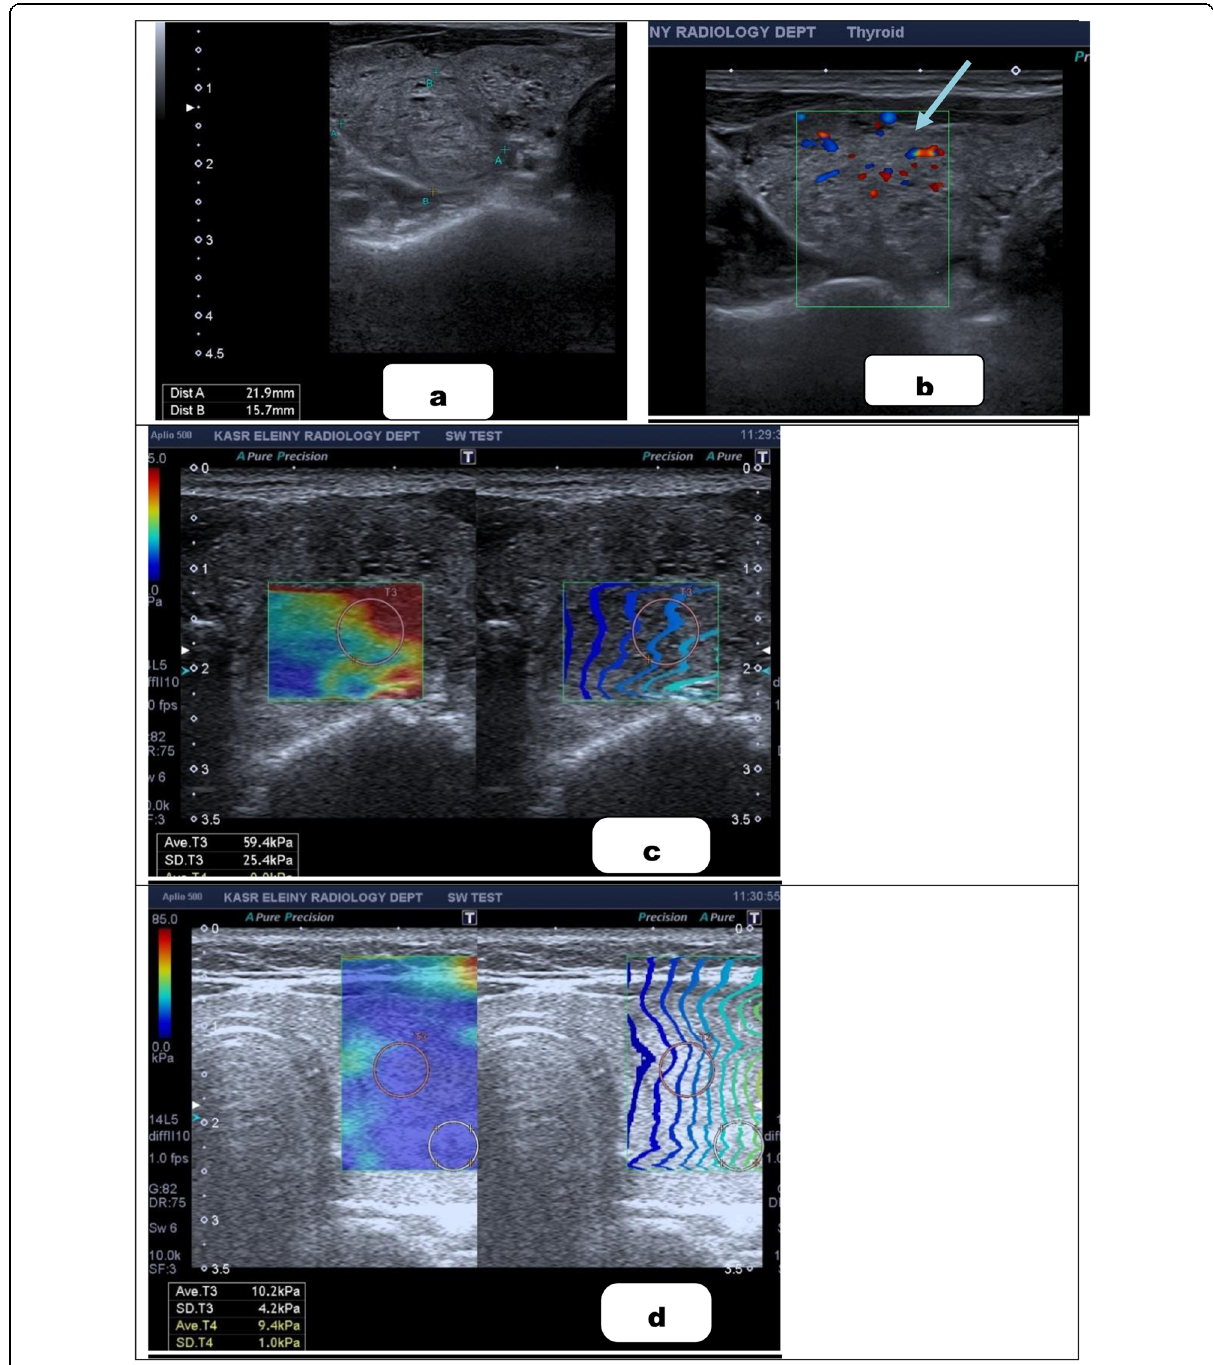
Fig. 6 Ultrasound images for a 58-year-old female patient. a Axial ultrasound B-mode image is showing two solid thyroid nodules that are isoechoic with calcification (TI-RADS 5). b Axial color image is showing internal vascularity (1b) (arrow). c Axial SWE of the thyroid nodule ( E mean = 59.4 kPa and ER = 5.8). d Axial SWE of the normal left thyroid parenchyma; the FNAC revealed malignant cells with psammomatous calcification (Bethesda 5), and the post right hemithyroidectomy histopathological examination had confirmed the presence of papillary thyroid